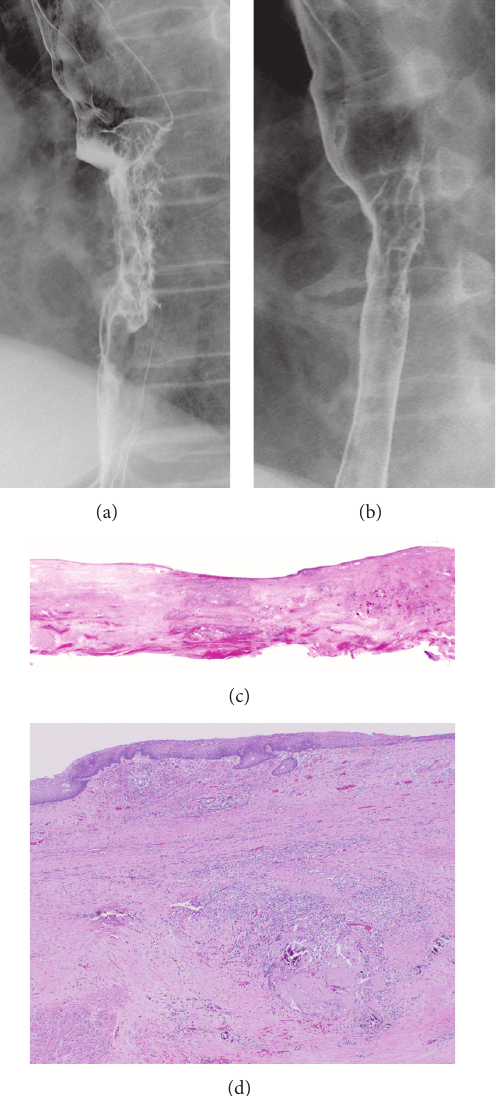
Figure 2: 76-year-old male with esophageal cancer who obtained a grade 3 pathologic response. (a) Before NACRT, esophagography shows irregular wall stenosis in the middle esophagus with the PES of 55.6%. (b) After NACRT, esophageal wall stenosis has improved result in the PES of 33.8%, which indicates the decrease in PES of 18.8%. (c), (d) Pathological specimen of the resected esophagus shows no carcinoma cells (grade 3). Many degenerative cells with keratinization and diffuse fibrosis are seen in the submucosa and muscularis propria.